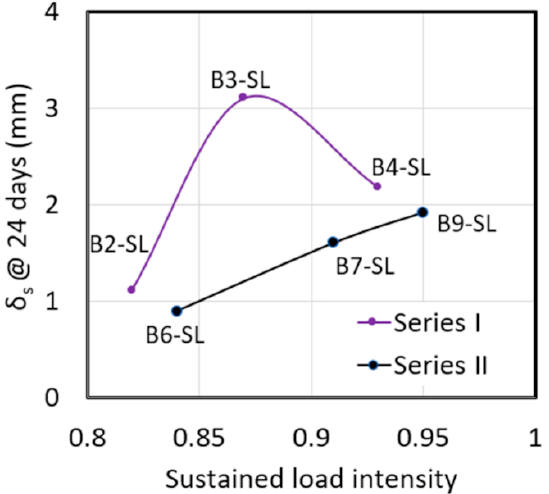
Figure 15. Deflection increases vs. sustained load intensity after 24 days of sustained load.